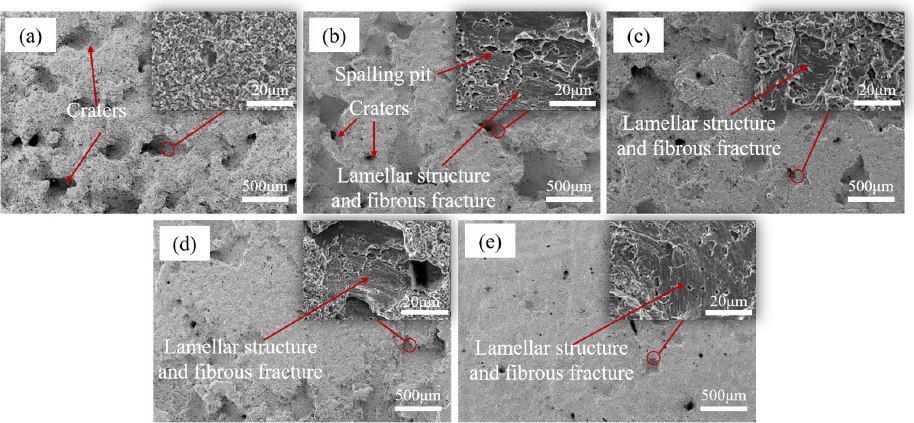
Figure 10. The surface morphologies of ( a ) 0Cr13Ni5Mo steel, ( b ) Cr20, ( c ) Cr25, ( d ) Cr25, and ( e ) Cr35 after CE for 20 h in distilled water.